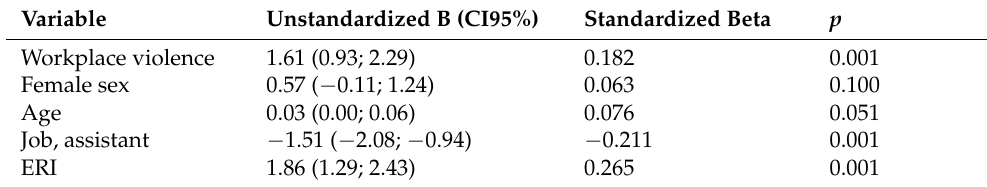
Table 5. Association of workplace violence with sleep quality. Multiple linear regression analysis.